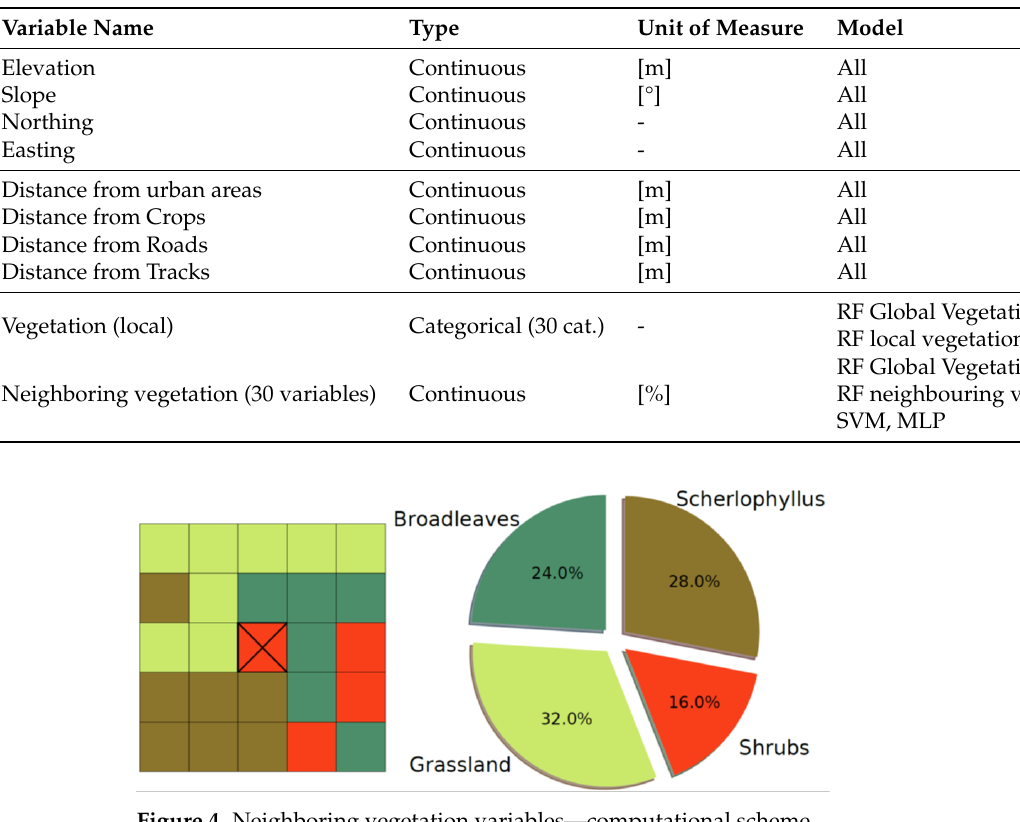
Table 1. List of the predictor variables adopted by the different ML models implemented in this work.